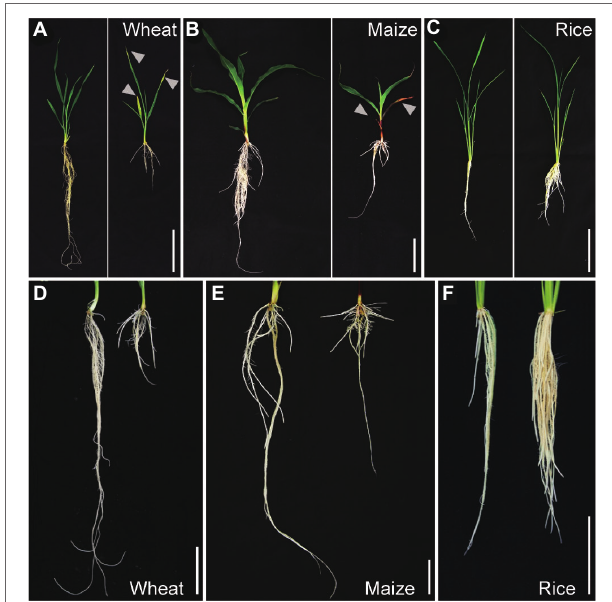
FIGURE 1 | Growth of wheat, maize, and rice under aerated or stagnant conditions. Pictures of seedlings of wheat (A) , maize (B) , and rice (C) and roots of wheat (D) , maize (E) , and rice (F) under aerated conditions (left) or stagnant conditions (right). Nine-day-old wheat, maize, and rice seedlings were further grown under aerated or stagnant conditions for 7 days. Yellowing or brownish parts of leaves are indicated by arrowheads. Bars = 10